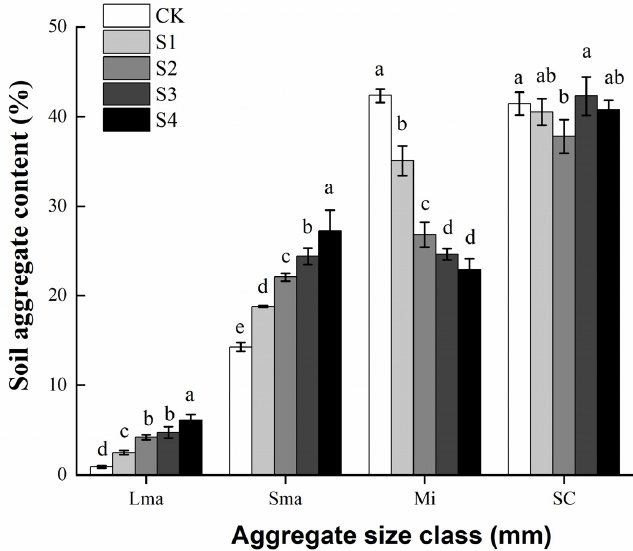
Figure 2. Effects of straw return on the size classes of soil aggregates. Different letters within a size fraction denote significant differences between treatments ( p < 0.05). CK, S1, S2, S3, and S4 represent rates of return of corn straw of 0, 6000, 9000, 12,000, and 15,000 kg hm − 2 , respectively. >2.00 mm, large macroaggregates; 2.00–0.25 mm, small macroaggregates; 0.25–0.053 mm, microaggregates; <0.053 mm, silt plus clay.